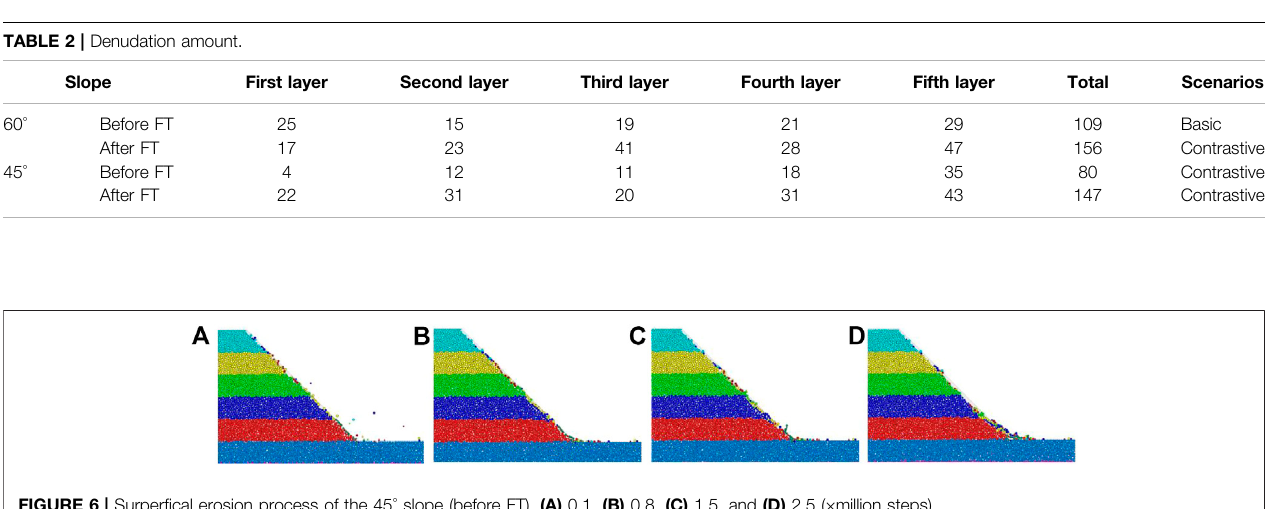
FIGURE 6 | Surper fi cal erosion process of the 45 ° slope (before FT). (A) 0.1, (B) 0.8, (C) 1.5, and (D) 2.5 ( × million steps).